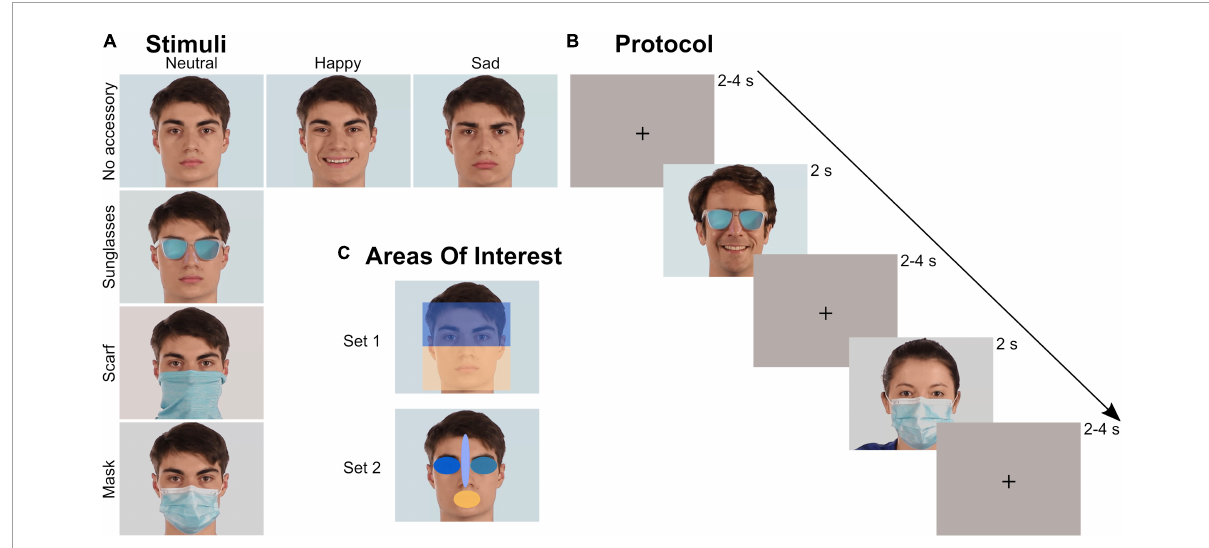
FIGURE1 Stimuli and protocol. (A) Stimuli: videos of four actors (2 males) with four occlusion and three emotion conditions were tested. (B) Protocol: each video lasted 2 s and was preceded by a 2–4 s inter-trial uniform image with a black cross. The 48 videos were randomly presented during a block. Three blocks were recorded by participant. (C) Areas of Interest (AOI): two sets of AOIs were created to analyze the ocular exploration. Within each set, the different AOIs covered the same